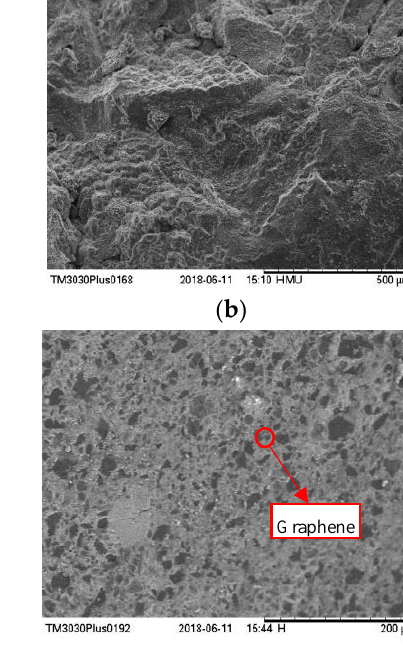
wt.% Al 2 O 3 nanopowder, ( c ) HITEC salt/2 wt.% graphene, ( d ) solar salt/2 wt.% graphene.